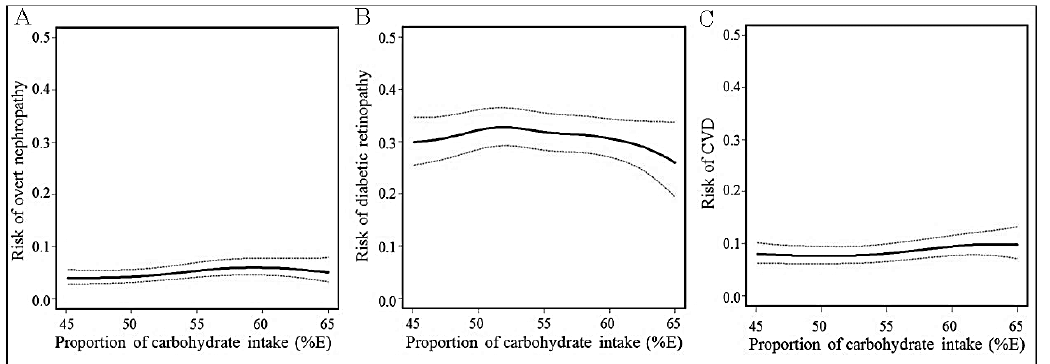
Figure 1. Incidence rate (solid curve) and 95% CI (broken curve) of 8 ‐ year overt nephropathy (Panel A ), diabetic retinopathy (Panel B ), and CVD (Panel C ) in relation to proportion of carbohydrate intake at baseline estimated by the generalized additive model. Abbreviation: CVD: cardiovascular disease.